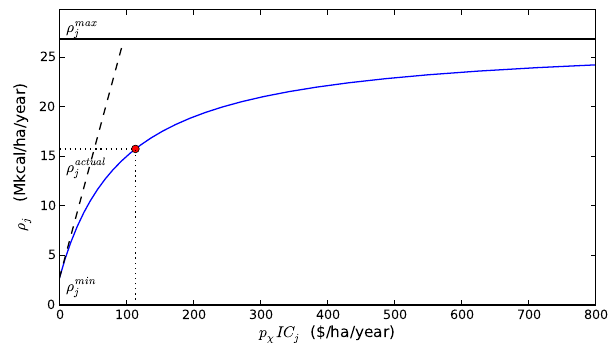
Fig. 7. Potential yield computed with national crop repartitions in rainfed conditions, average over the 1999–2003 period.